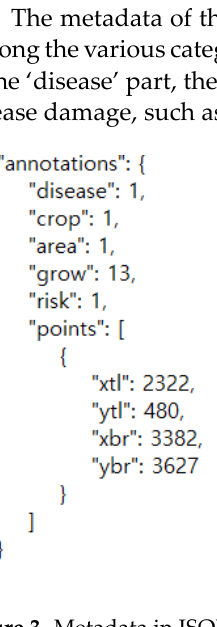
Figure 3. Metadata in JSON form provided to each